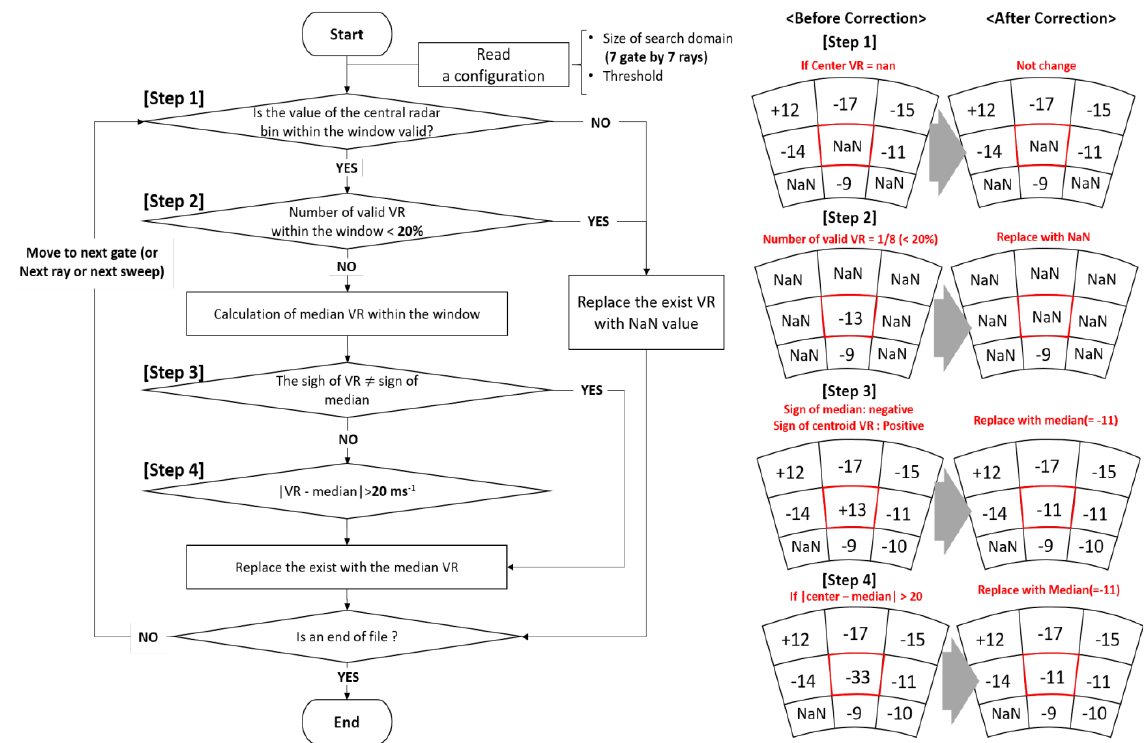
Figure 4. Flowchart for noise correction and conceptual diagram for noise correction based on the sign of median radial velocity.